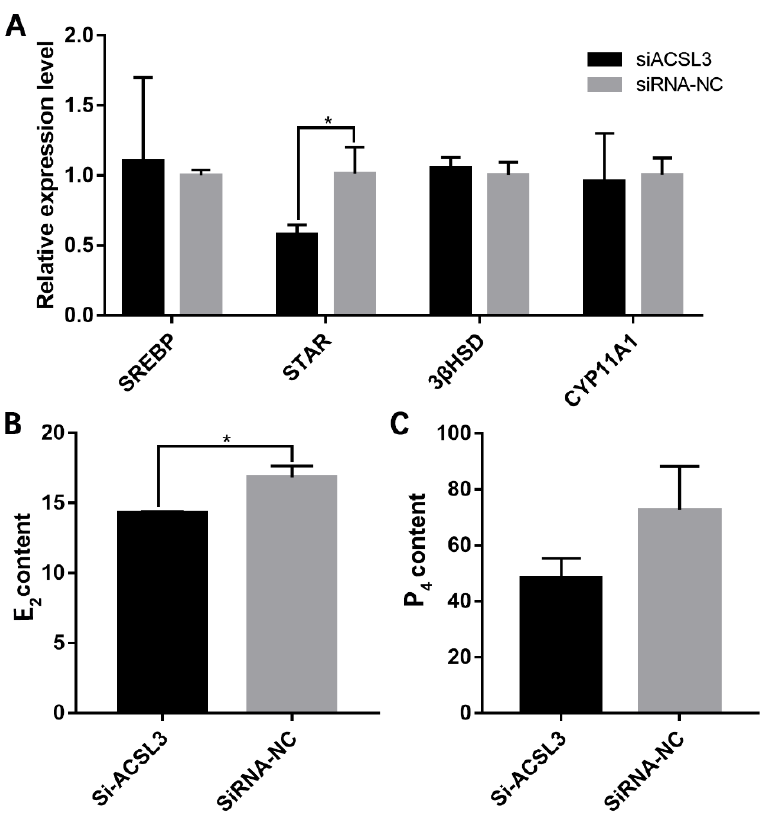
Figure 6. ACSL3 inhibition decreased steroid hormone synthesis. ( A ) effects of si-ACSL3-1877 on the expression levels of several steroidogenesis-related genes, and ( B , C ) effects of ACSL3 inhibition on the secretion of E2 and P4. * p < 0.05.